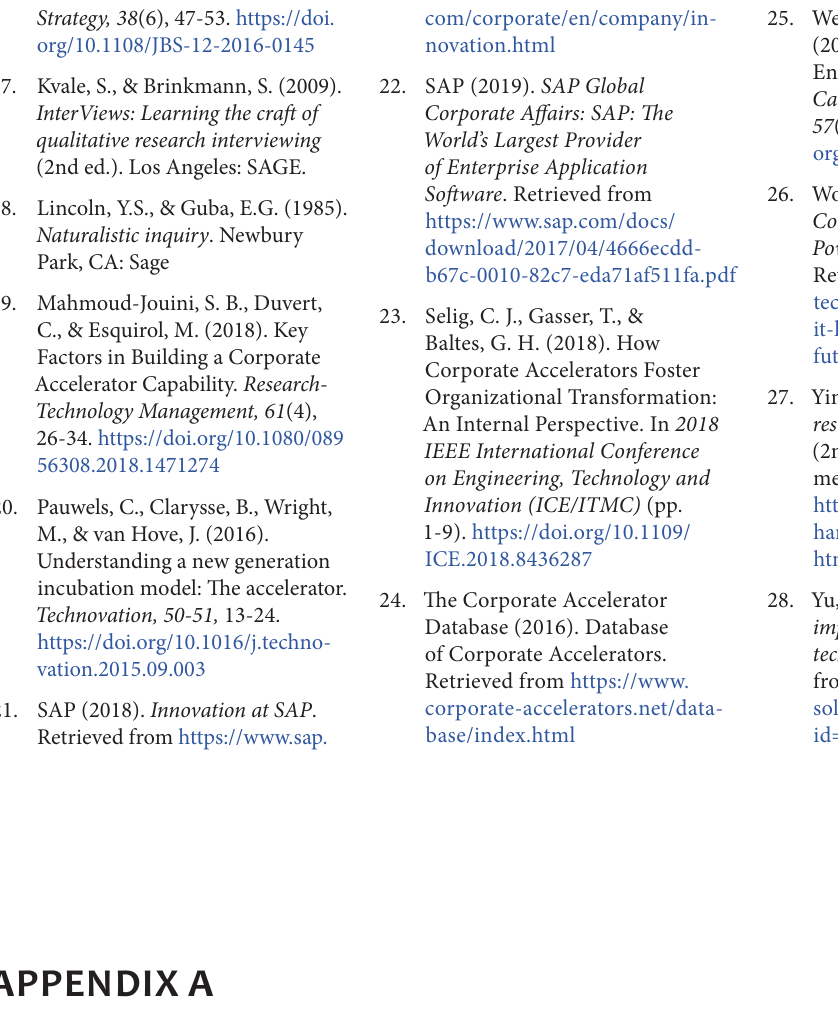
Table A1. Overview of innovation, incubation and venturing activities at